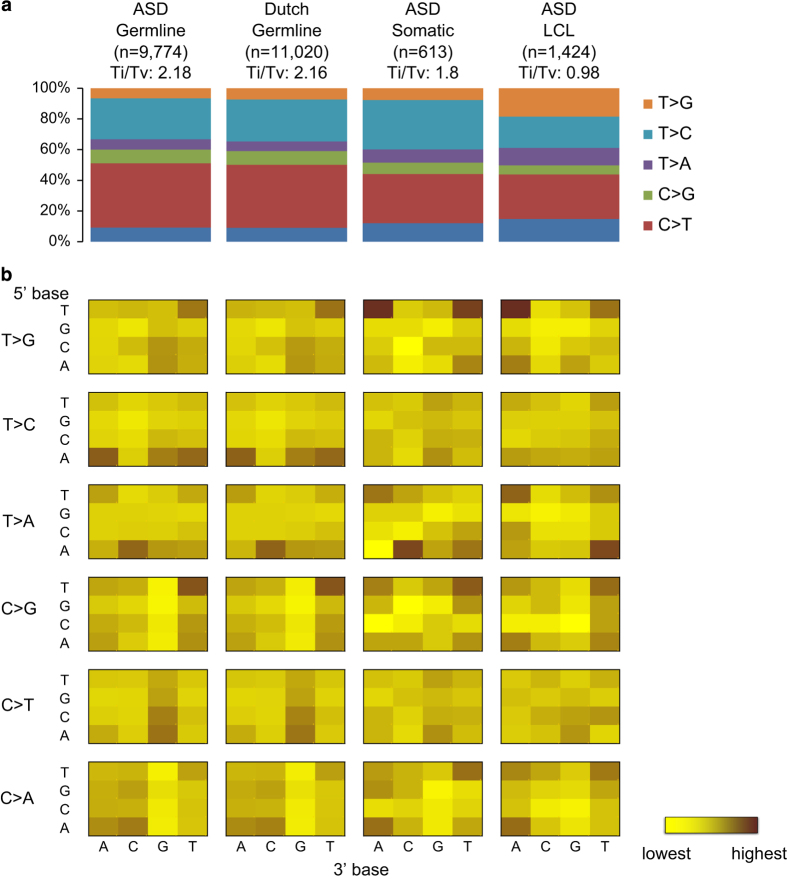
Sequence context of regions with de novo mutations. (a) Transition (Ti) to transversion (Tv) ratio of different kinds of de novo mutations found in: germline of ASD, germline of Dutch population controls, somatic events of ASD and lymphocyte-derived cell line (LCL) of ASD. (b) Sequence context of the base substitution mutation spectra for different de novo mutations. Each of the 96 mutated trinucleotides (mutated position at centre) from each cohort is represented in a heatmap (intensity of colour correspond to frequency of each mutation). The 5′ base to the mutated site is shown on the vertical axis, while the 3′ base is shown on the horizontal axis.